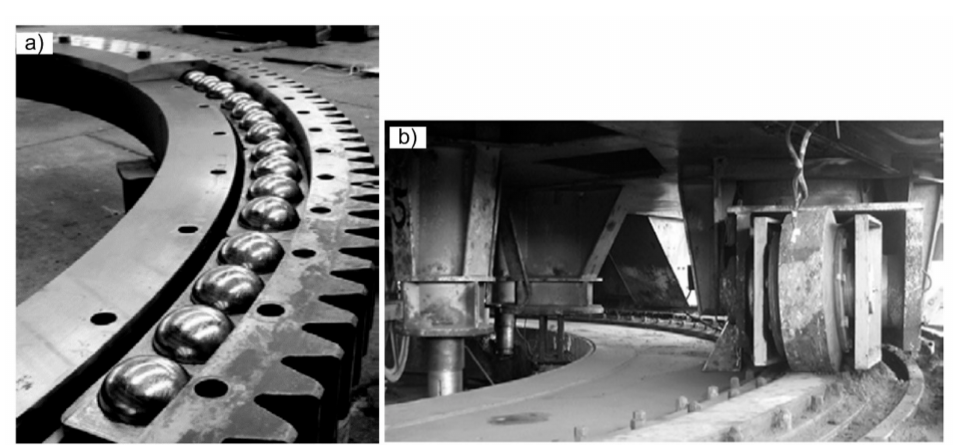
Figure 2. Basic solutions of slewing units: ( a ) on a large-diameter rolling bearing, and ( b ) on wheeled bogies running on a rail track